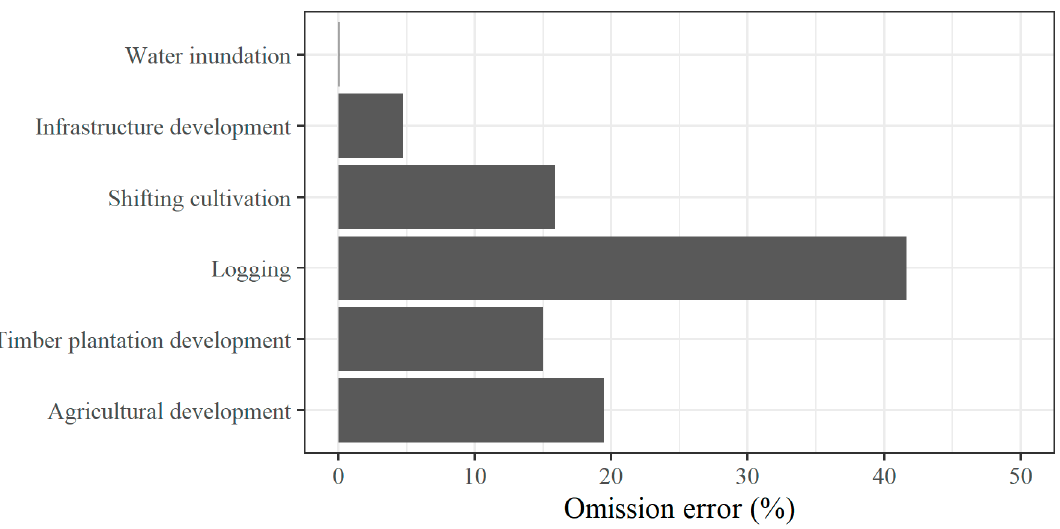
Figure 8. Omission error of disturbance for each disturbance agent using the combination of Landsat 8 and Sentinel-1.